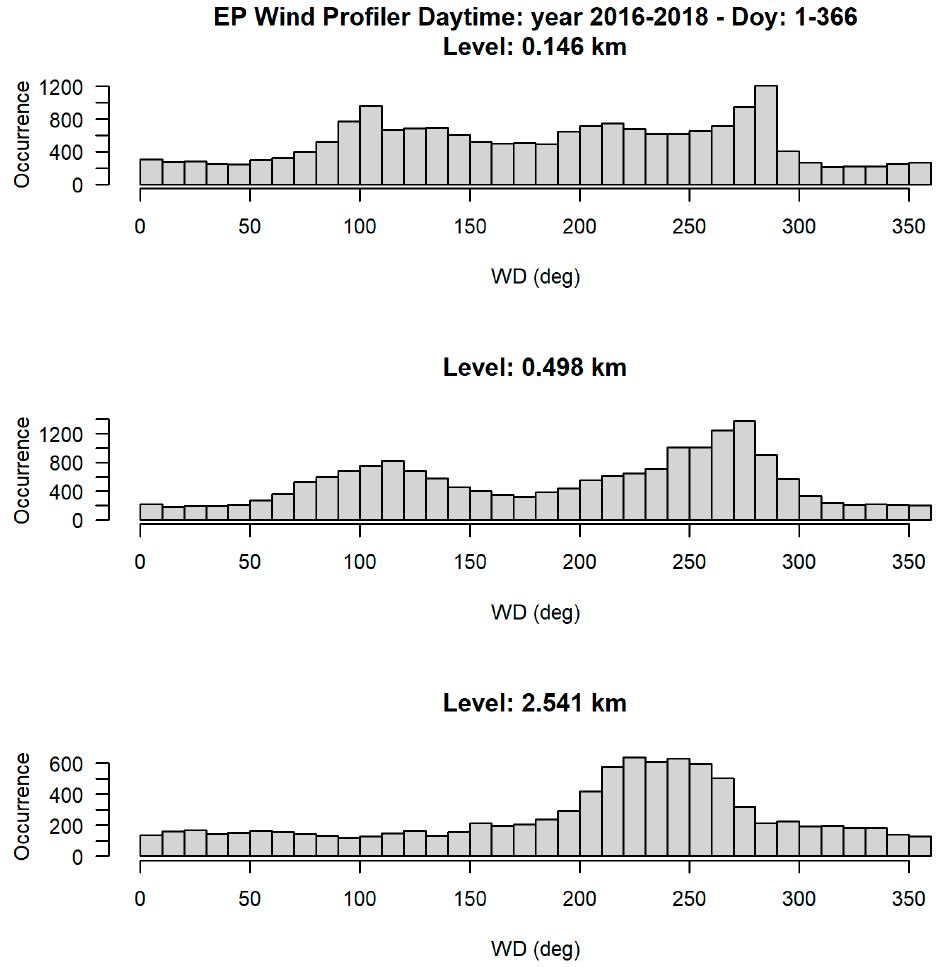
Figure 8. Histogram of wind direction at several levels ( top ) at 0.146 km ( middle ) at 0.498 km, and ( bottom ) at 2.251 km.